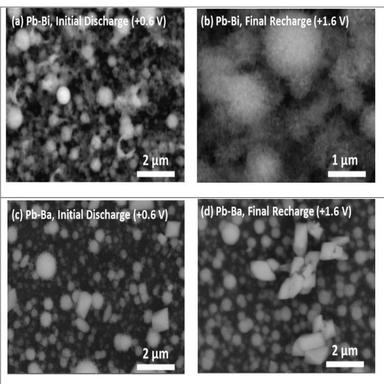
(a) The Pb-Bi after initial discharge. (b) Pb-Bi after final recharge. (c) Pb-Ba after initial discharge. (d) Pb-Ba after final recharge.